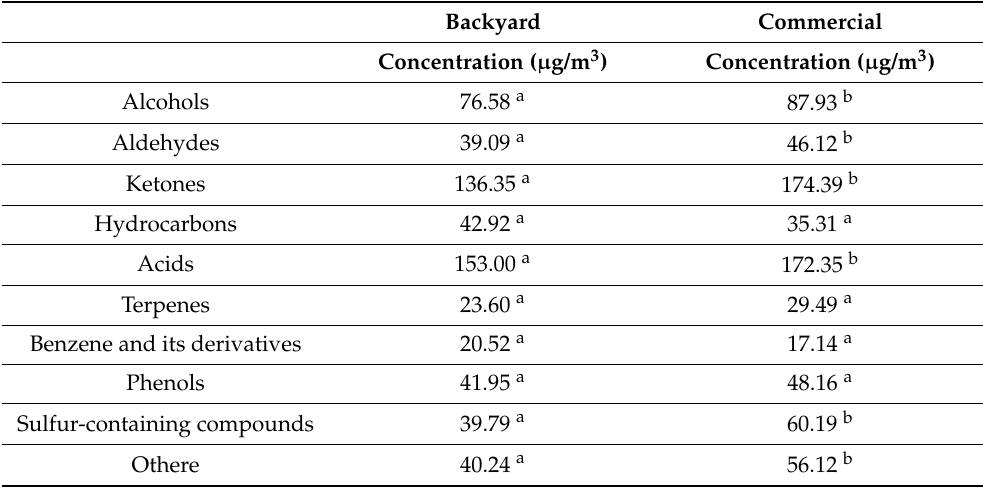
Table 6. Differences for the mean values of individual groups of compounds depending on the breeding system.